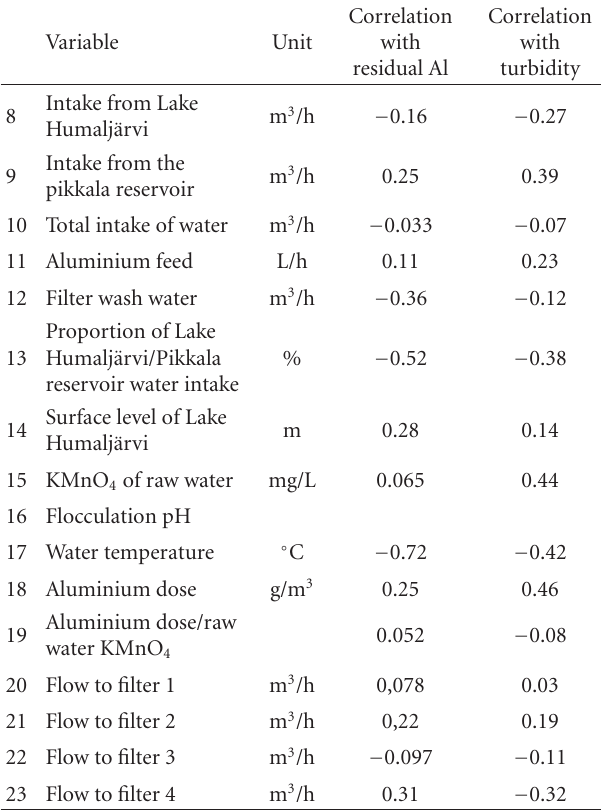
Table 2: Process variables used for modelling and their correlations with residual Al and turbidity. Variable Unit